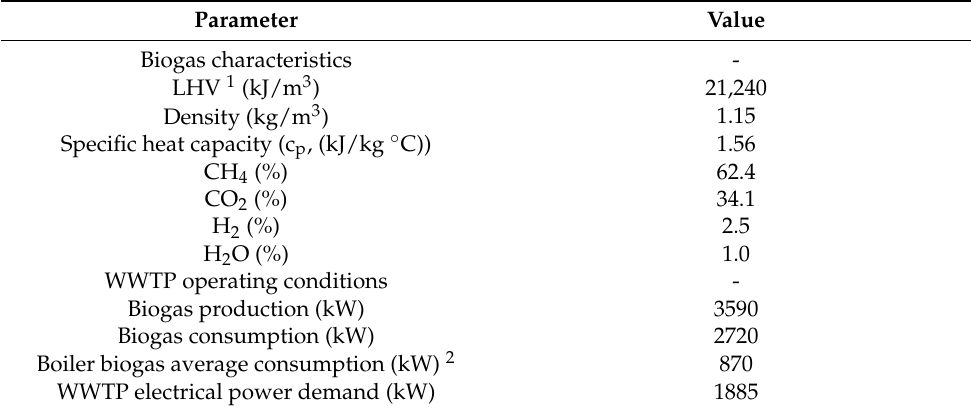
Table 1. Biogas parameters, operating point and electricity demand of the Burgos WWTP. Biogas reported at standard temperature and pressure (STP)